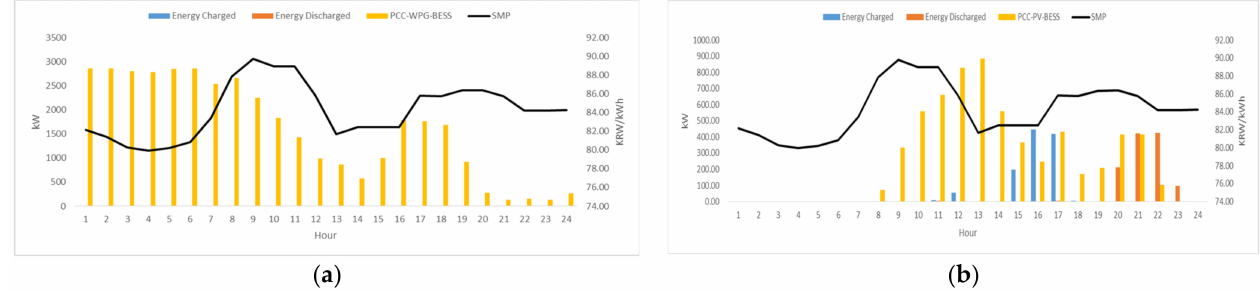
Figure 10. Operation of the BESS and the PV in coordination without profit maximization: ( a ) intraday operation of the BESS with WPG without profit maximization; ( b ) intraday operation of the BESS with the PV without profit